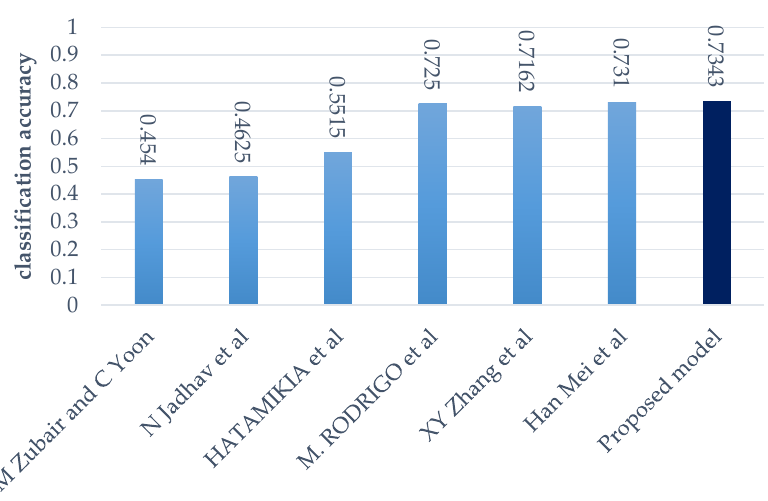
Figure 8. Four class classification accuracy.